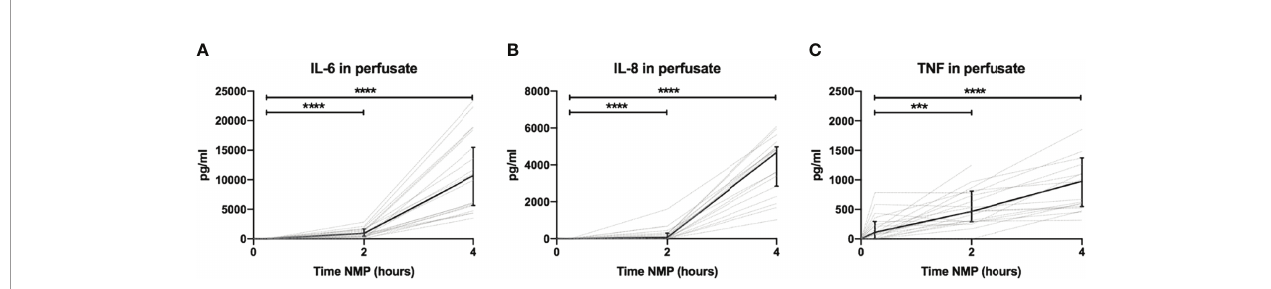
FIGURE 3 | Cytokine perfusate levels during normothermic machine perfusion of porcine kidneys. Dynamics of pro-in fl ammatory cytokines (A) IL-6, (B) IL-8, and (C) TNF in perfusate during normothermic machine perfusion of porcine kidneys. Cytokine perfusate levels signi fi cantly increased during 4 h of normothermic machine perfusion. Dotted lines: increase of cytokine levels in perfusate per individual perfused kidney. Solid lines and bars: median ± interquartile range of cytokine perfusate levels for all kidneys ( n = 20). *** p < 0.001, **** p < 0.0001. IL-6, interleukin-6; IL-8, interleukin-8; NMP, normothermic machine perfusion; TNF,